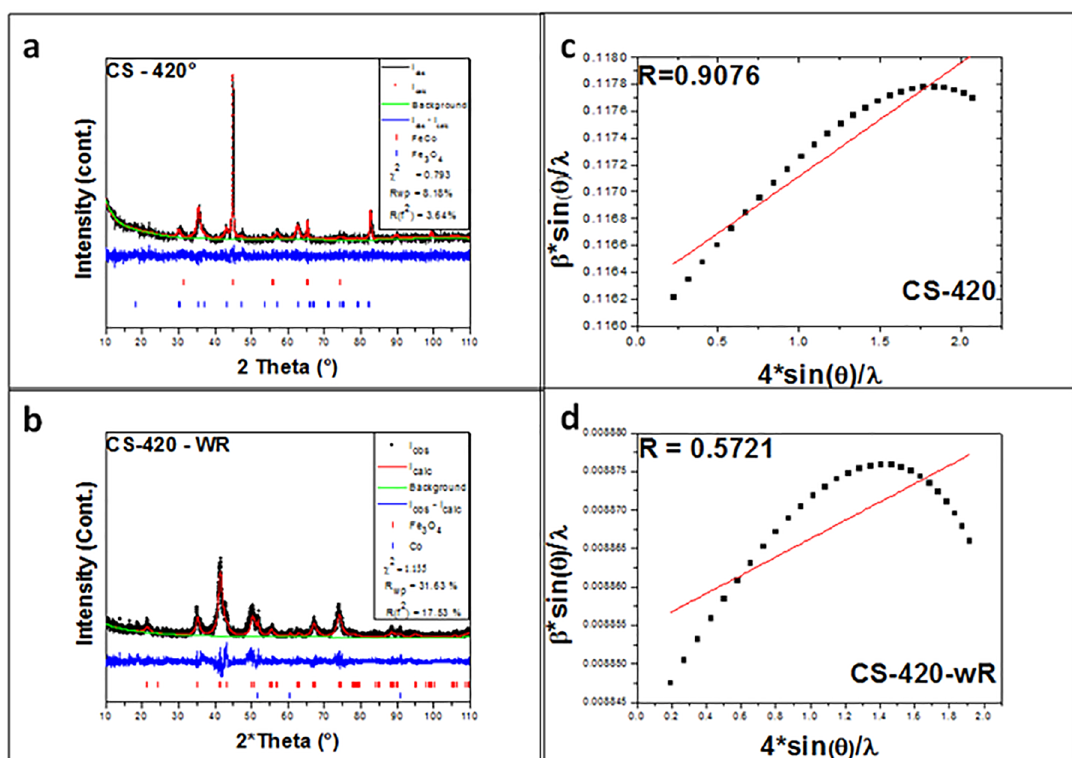
Figure 10. a) Diffractograms and b) Williamson-Hall plot for the solid CS-420 with and without